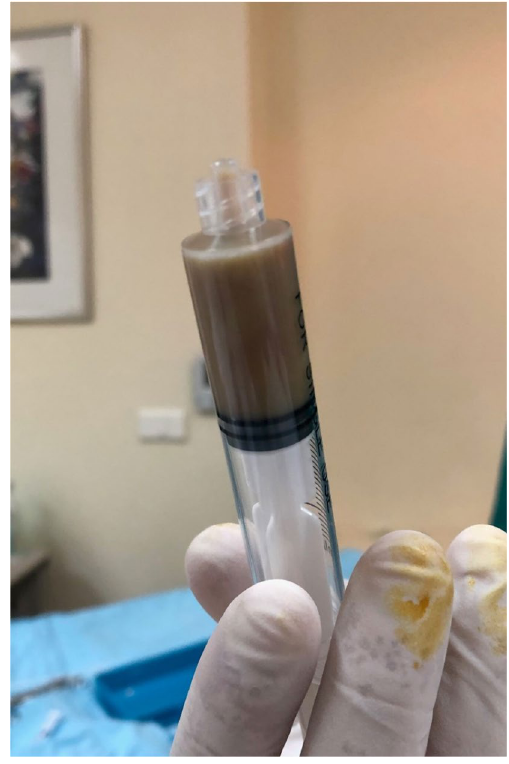
Fig. 4 Aspirated thick